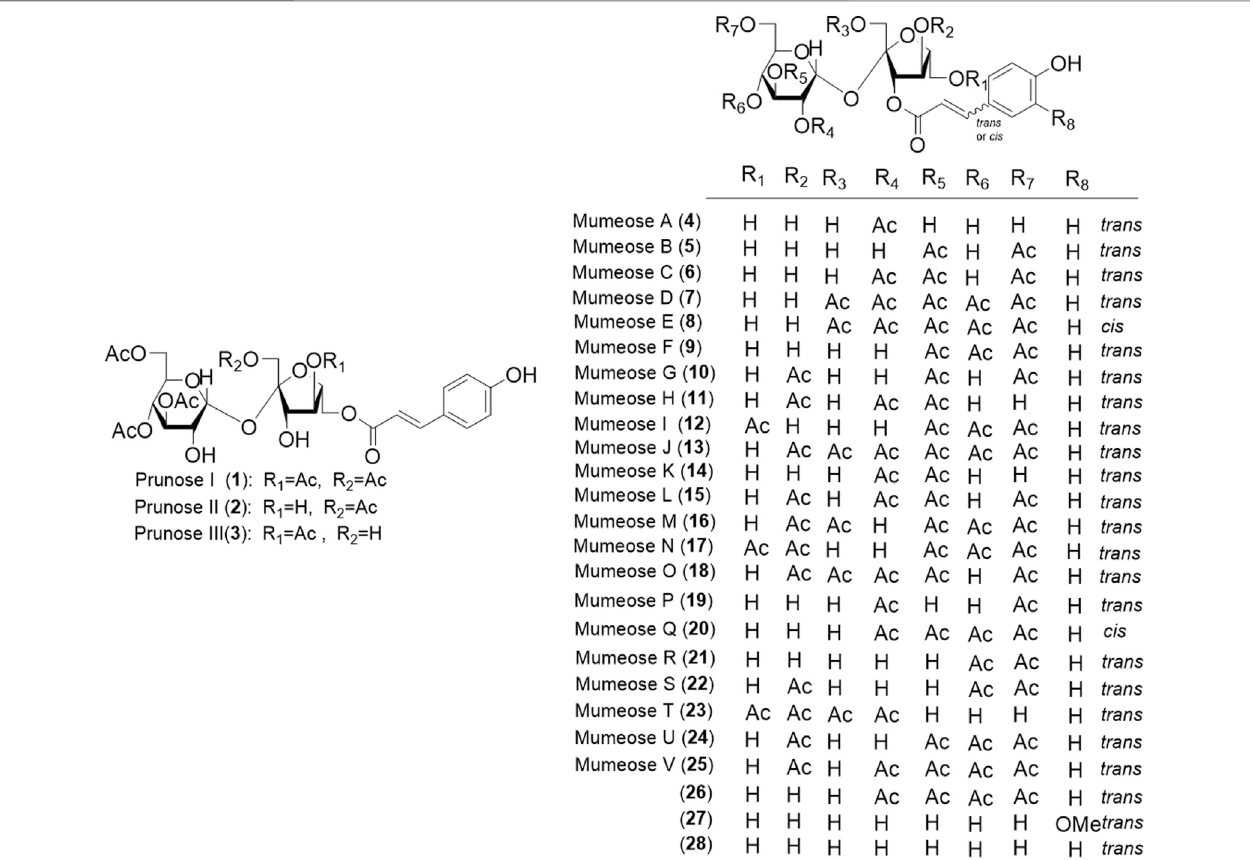
Frontiers in Pharmacology |